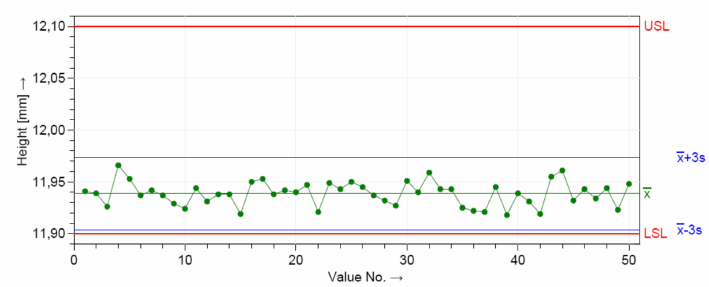
Figure 6. Control chart for the short-term capability study of the height dimension